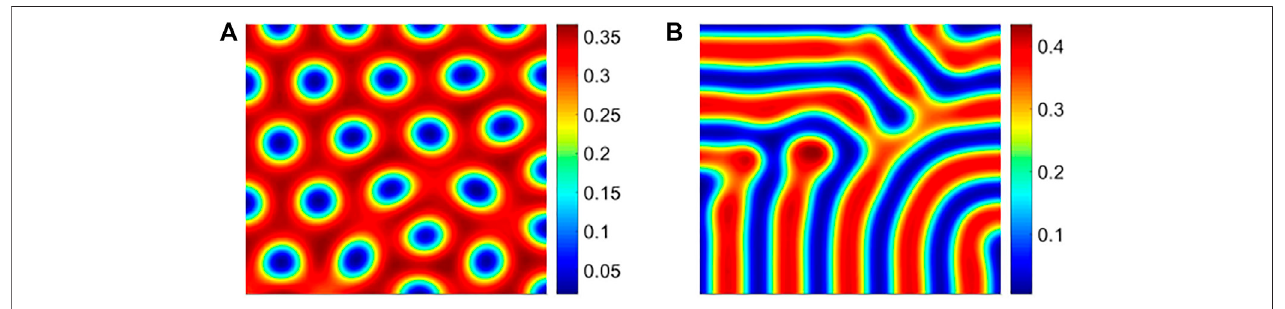
FIGURE 6 | Different pattern structures of prey population. (A) Cold spot pattern with γ = 1.95; (B) stripe pattern with γ = 2.05.